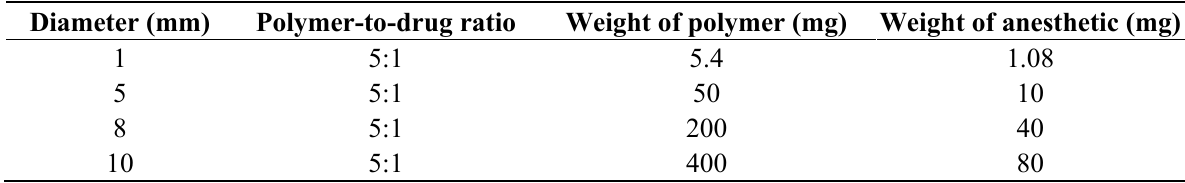
Table 2. Dimensions and compositions of the lidocaine/PLGA pellets of different sizes. Diameter